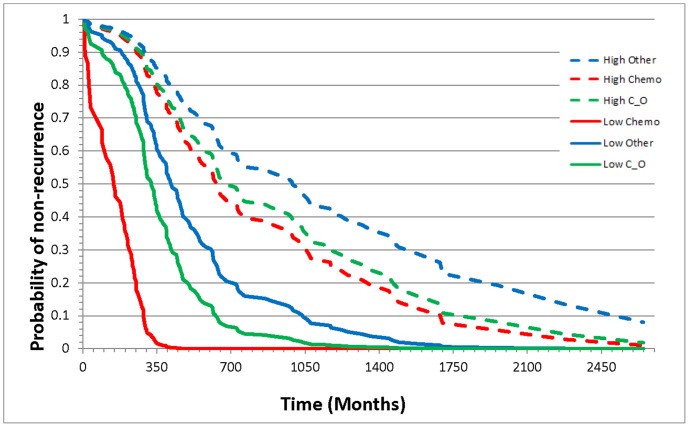
Probability of ovarian cancer non-recurrence for patients receiving the treatment chemotherapy only, chemotherapy along with another treatment, or some other treatment or combination of treatments except chemotherapy that have high or low levels of hsa-miR-497.